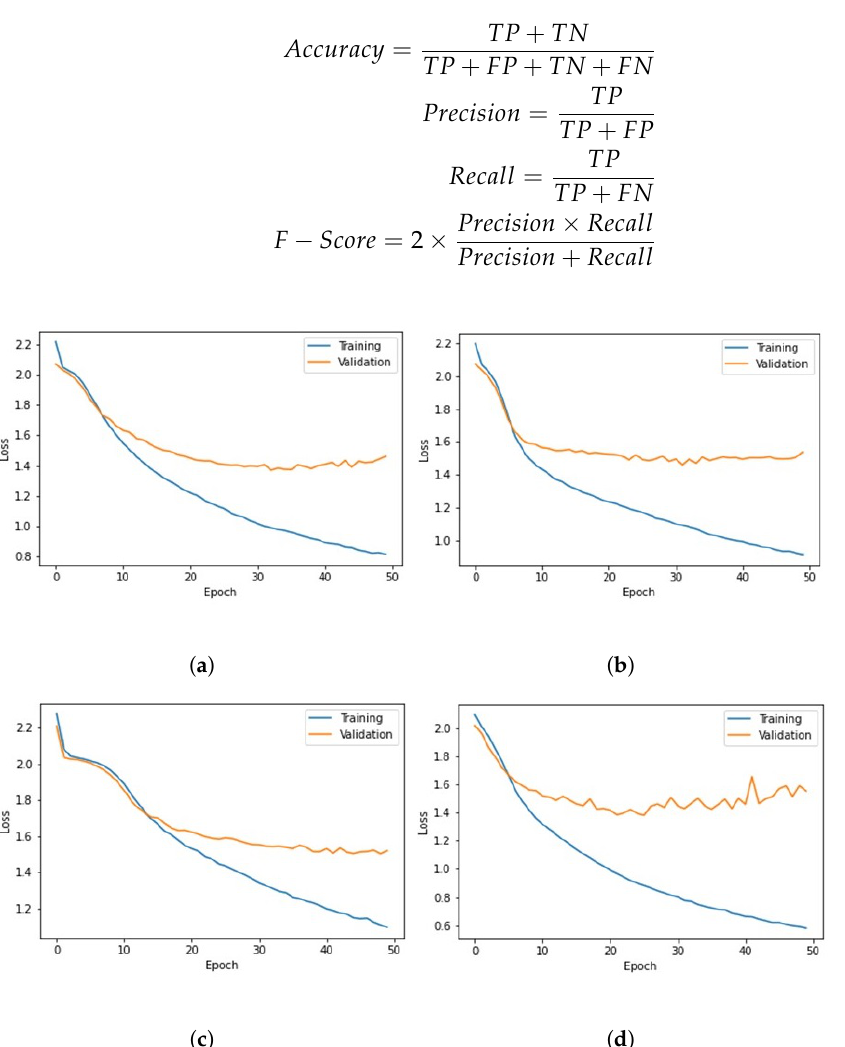
Figure 8. Training and validation loss. ( a ) BiLSTM loss; ( b ) BiGRU loss; ( c ) BiGRNN loss; ( d ) AFED